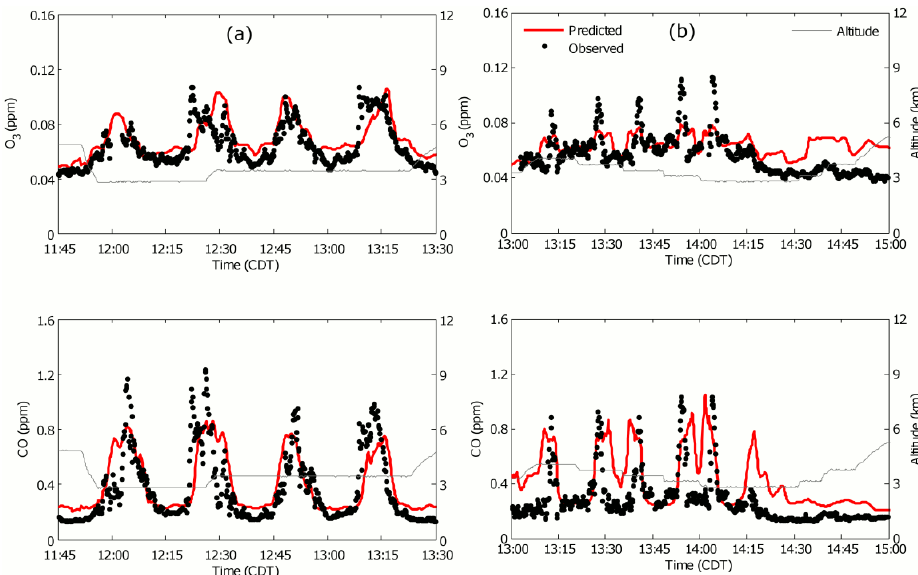
Fig. 7. Time series for ozone and CO along the G-1 flight track on (a) 27 and (b) 7 March. Each measurement was taken at a 10-second interval, and simulations were temporally and spatially interpolated simulations to correspond each measurement. Gray line indicates the G-1 flight altitude.